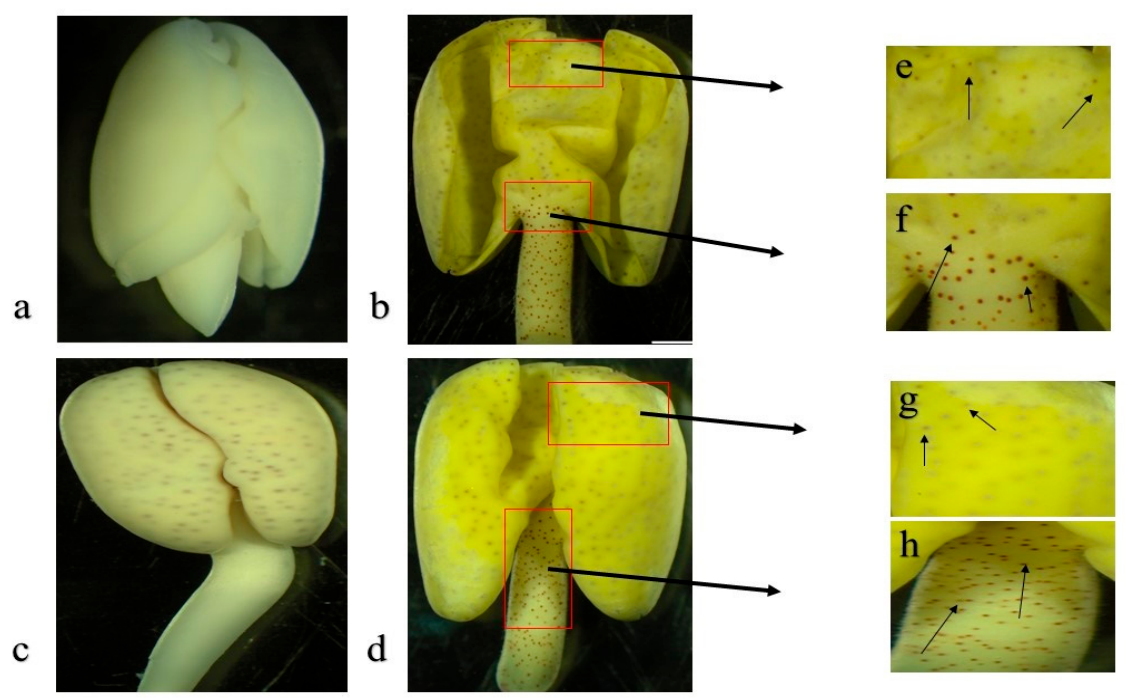
Figure 1. Pictorial description of delayed gland morphogenesis in Gossypium bickii and regular gland formation in Gossypium arboreum showing glands on seeds and germination stages. ( a ) Imbibed seed image of G. bickii showing no glands; ( b ) seed germination stage of G. bickii showing glands on cotyledons and hypocotyl; ( c , d ) image of G. arboreum imbibed seed and germination showing glands; ( e , f ) gland formation in cotyledon and hypocotyl of G. bickii ; and ( g , h ) gland formation in cotyledon and hypocotyl of G. arboreum